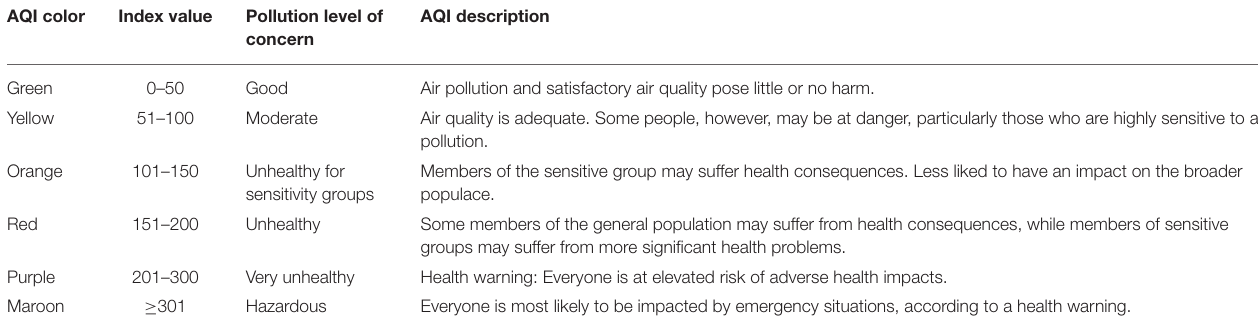
TABLE 5 | Recommendation of Air Quality Index (AQI) classification by U.S. EPA (32).